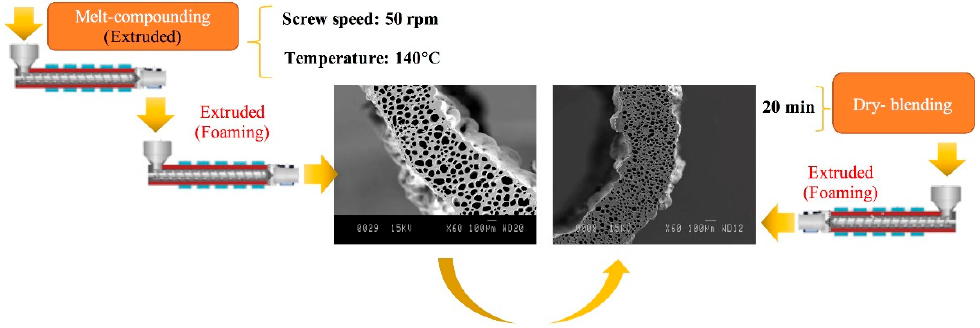
Figure 6. Effect of the production method on the MMFM morphology with 15 wt % zeolite: ( left ) melt compounding and ( right ) dry blending.